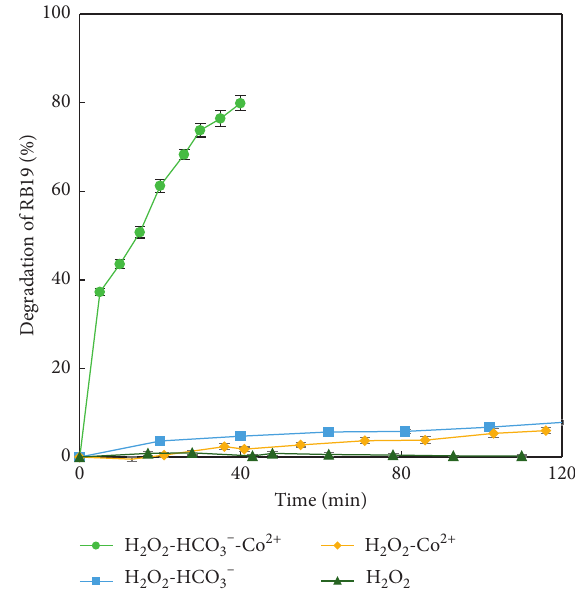
Figure 4: Comparison of the degradation of RB19 by H − Co 2 + , H O H 2 2